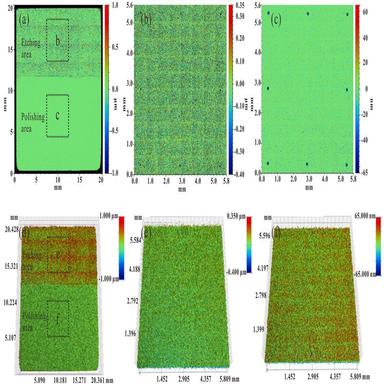
Information of surface profiles for the TC4 titanium alloy after the filtering process: (a) 2D surface profile, with corresponding 3D surface profile morphology as (d); (b) magnified image of the rectangular area in (a), with corresponding 3D surface profile morphology as (e); (c) magnified image of the rectangular area in (a), with corresponding 3D surface profile morphology as (f).